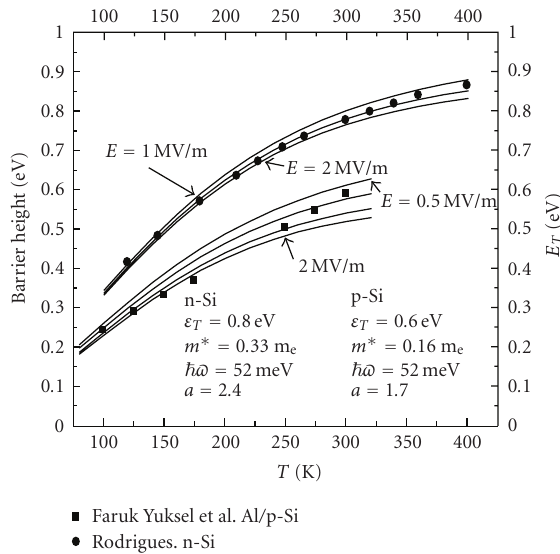
Figure 8: Temperature dependence of the barrier height for n- Si from [26] and Al/p-Si [27] symbols, fitted to the E T versus T dependences (solid